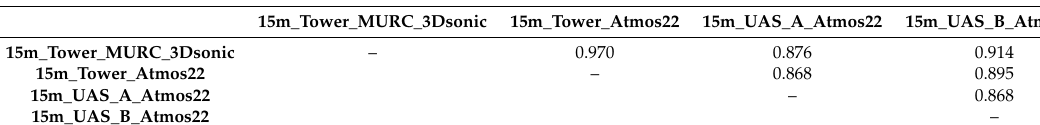
Table 2. Pearson correlation coefficients for wind speed measurements between different UAS packages and ground-based sensors.